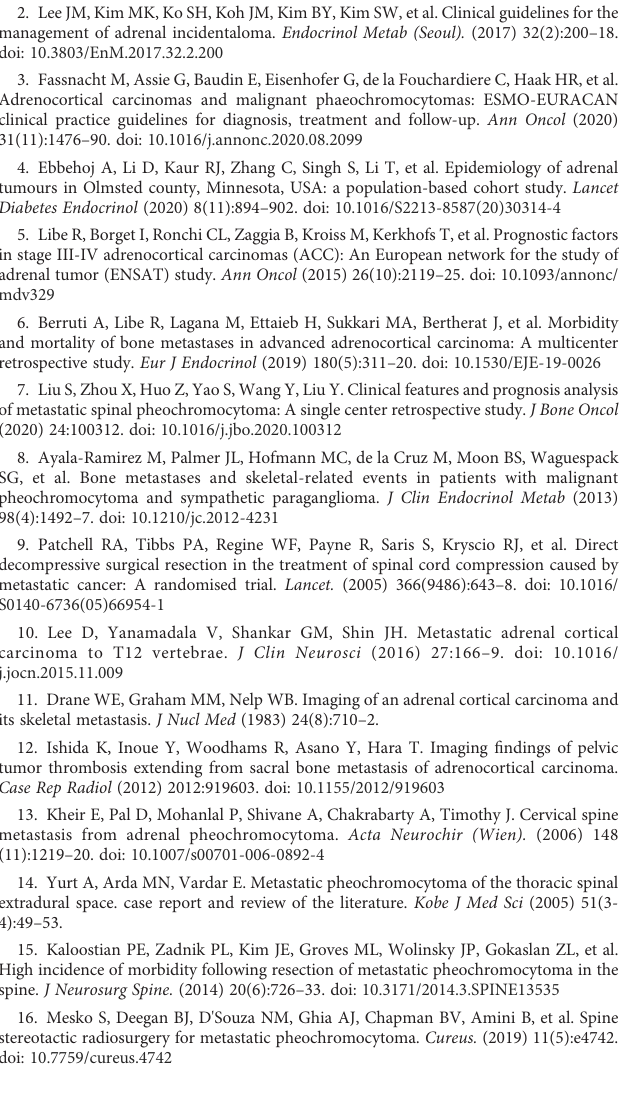
prognostic score was 5 points. So, we chose the surgical strategy of total piecemeal resection. The tumor was excised by total piecemeal resection, pedicle screws, titanium mesh and titanium rods were used to reconstruct the stability; (G, H) Postoperative X-ray; (I – K) Postoperative sagittal, transverse, and coronal MRI. SUPPLEMENTARY FIGURE 1 (A – C) Preoperative sagittal, coronal, and transverse MRI images of L1-L2 vertebral body tumors; (D) Preoperative transverse CT scan showed L1-L2 vertebral body tumors; (E) He had a history of adrenal tumor (4 points). Visceral metastases were not detectable (0 point). Bone metastases were isolated (1 point). His total prognostic score was 5 points. So, we chose the surgical strategy of total en-bloc resection. The tumor was excised by total en- bloc resection, pedicle screws, titanium mesh, bone cement and titanium rods were used to reconstruct the stability; (F, G) Postoperative